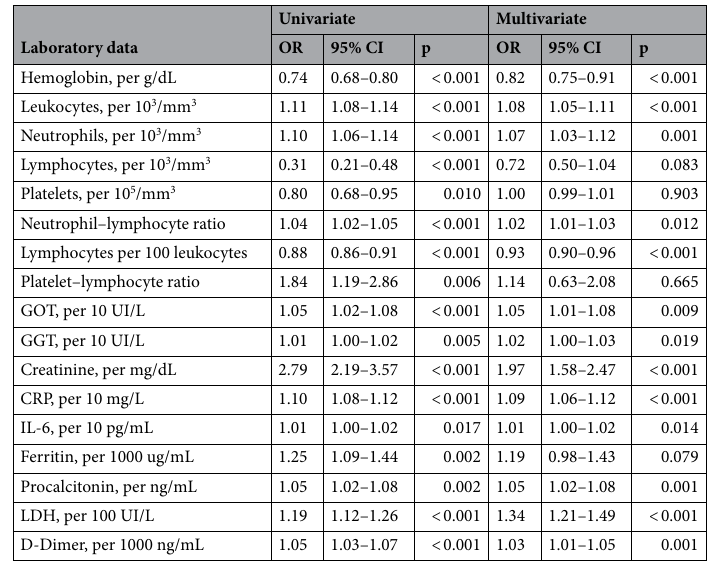
Table 2. Univariate and multivariate analysis for biomarkers to predict mortality. Multivariate adjustment: Age, comorbidities (hypertension, dyslipemia, diabetes mellitus, peripheral artery disease, heart disease, COPD/asthma), days of symptoms, respiratory insufficiency, in-hospital drugs (antiviral, chloroquine, ceftriaxone, corticosteroids, anticoagulation, antiplatelet).